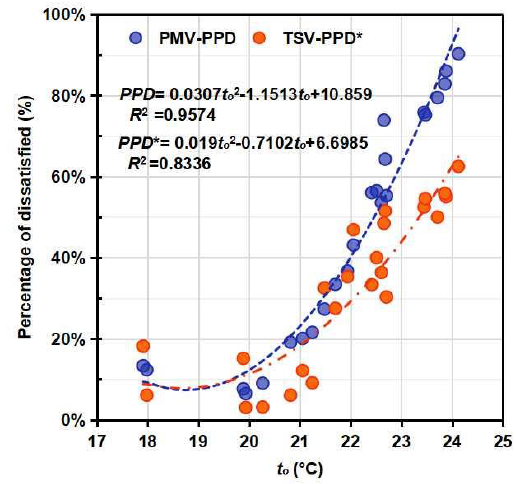
Figure 12. Regression relationship between the thermal dissatisfaction rate and the indoor temperature.